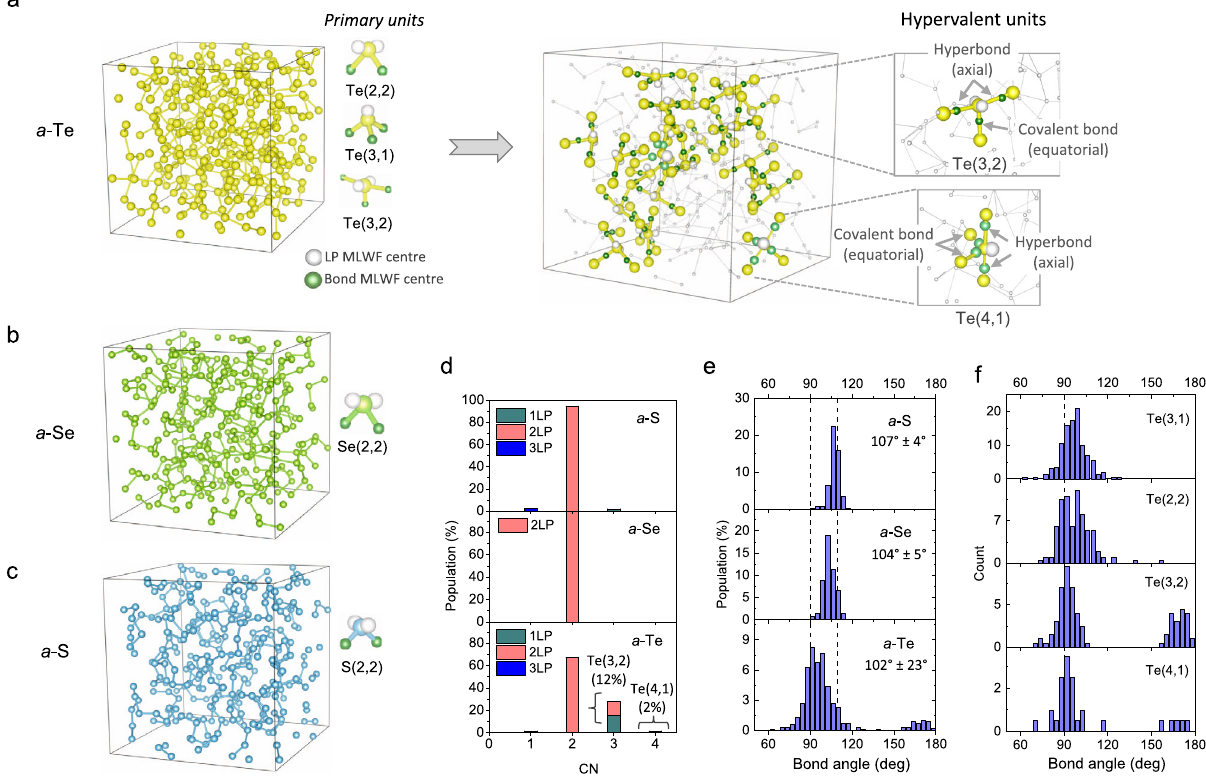
Fig. 1 Amorphous chalcogen models and their constituent structural building units. Amorphous models of: a a -Te; b a -Se; and c a -S, and their primary structural units. Each structural unit is speci fi ed by two numbers in parentheses, the former denoting the coordination number and the latter the number of LPs associated with the central (chalcogen) atom. For a -Te, hyperbonds, covalent bonds and lone pairs (LPs) are speci fi ed for each hypervalent unit in a . d Populations of structural units for each amorphous chalcogen model. The percentages of hypervalent units are noted. e Bond-angle distributions (BADs) for structural units found in each model, with the mean bond angle being speci fi ed. Bond angles of 90° and 109° are indicated by vertical dotted lines for reference. f BADs for various structural units in a